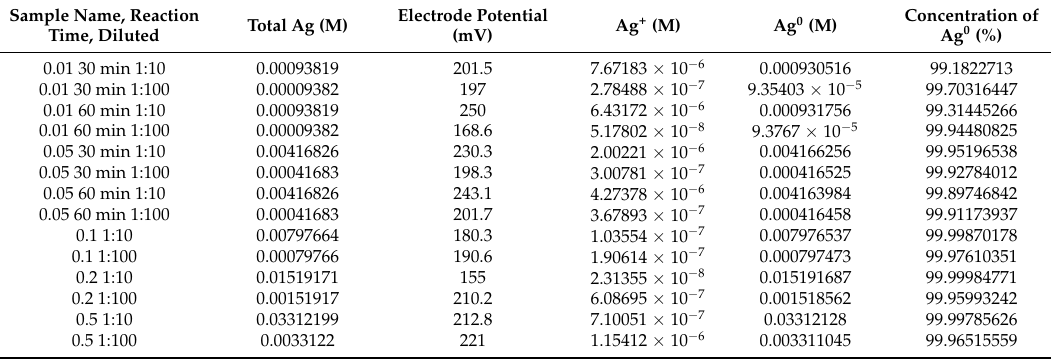
Table 4. Silver ion concentration by ion selective electrode measure and assessment of % Ag 0 .